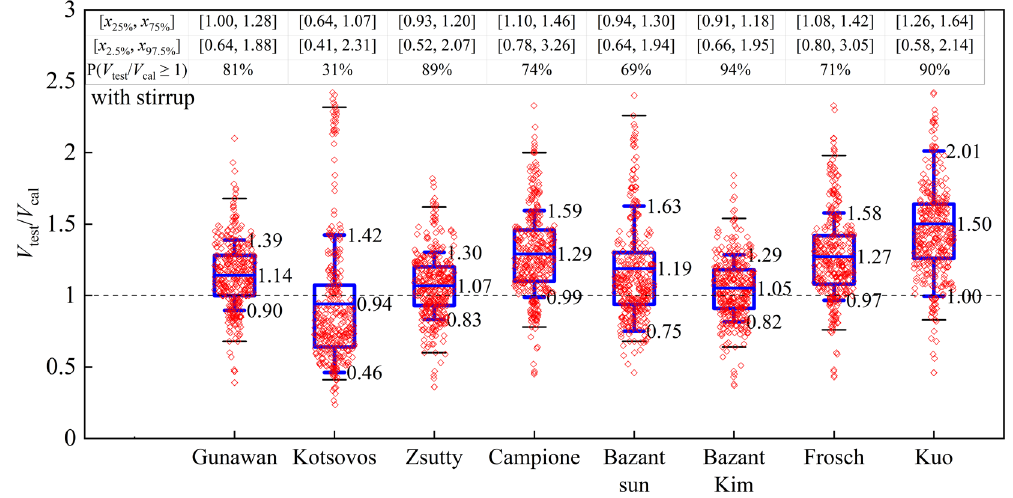
Figure 4. Researchers: overall prediction results for beams with stirrups.